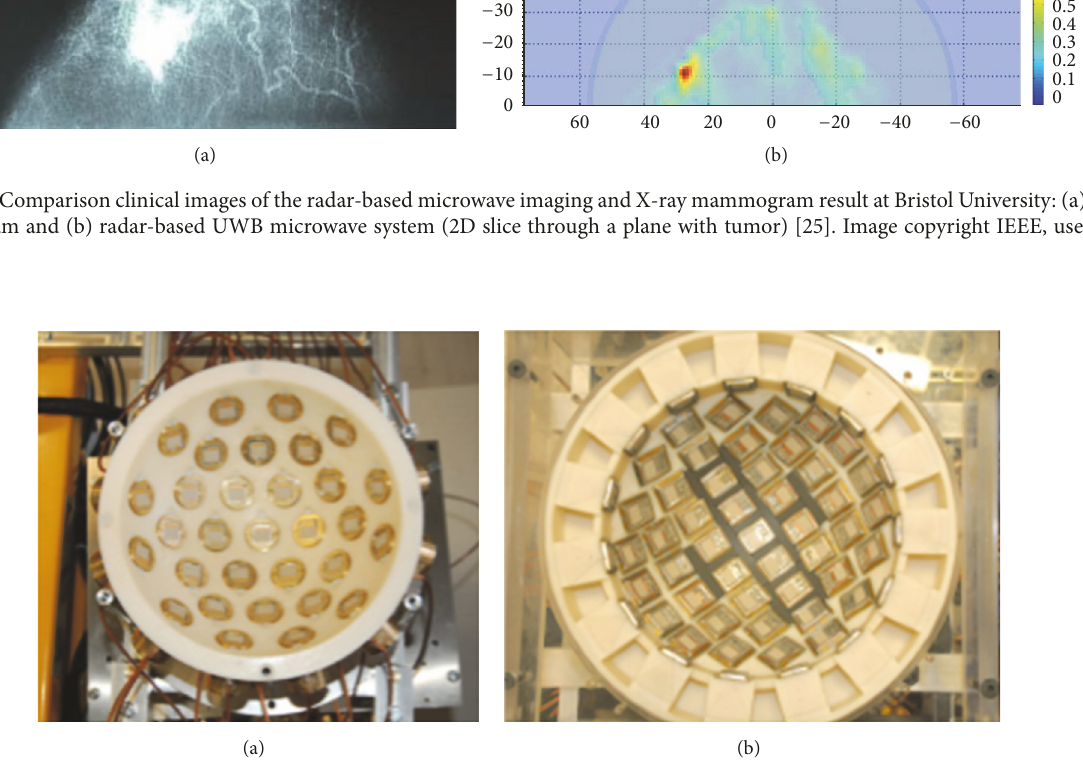
Figure 21: (a) 31-element prototype and (b) 60-element antenna array at Bristol University. Taken from [26]; copyright EurAAP; used with permission.